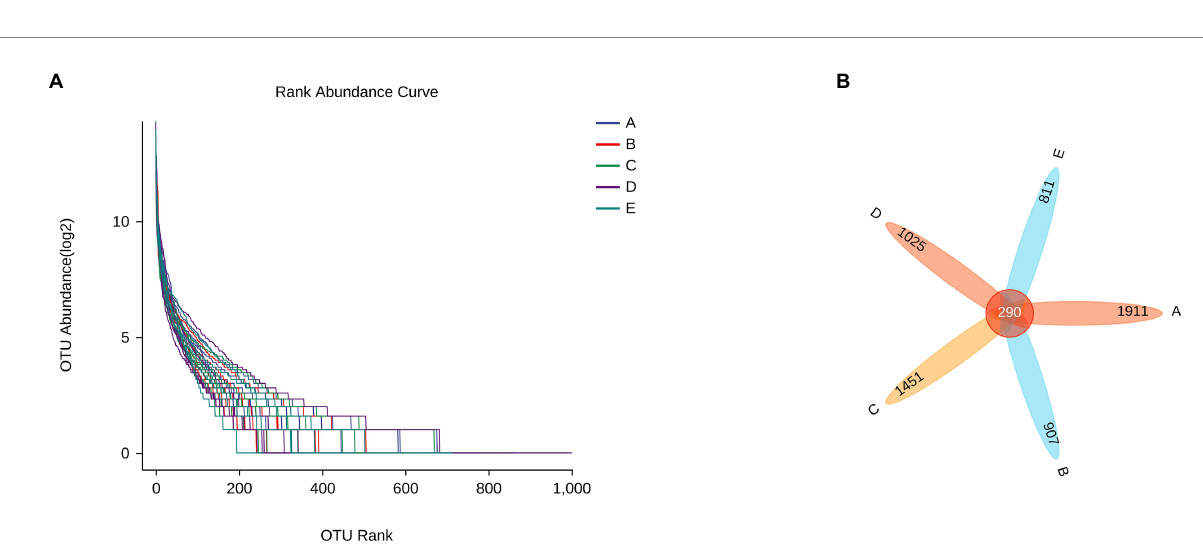
FIGURE 8 The effect of CSPCM on Rank abundance and OTU numbers in mice samples. (A) The effect of CSPCM on Rank abundance. (B) The effect of CSPCM on OTU